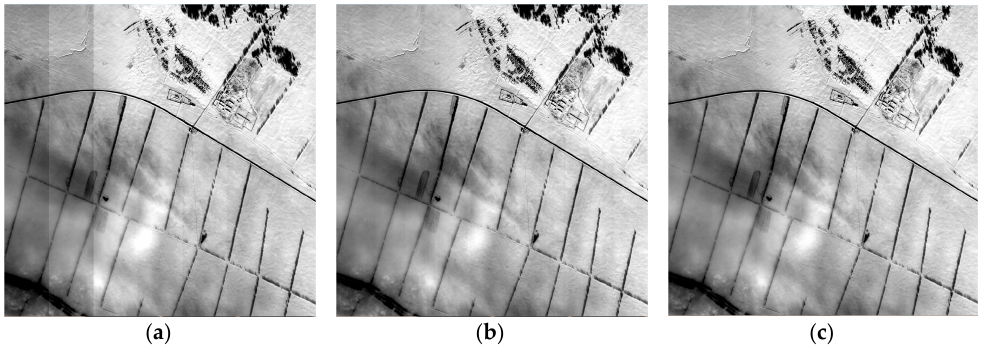
Figure 12. The raw and corrected images of the desert. ( a ) Raw image; ( b ) Image corrected using the on-orbit coefficients; ( c ) Image corrected using the side-slither coefficients.